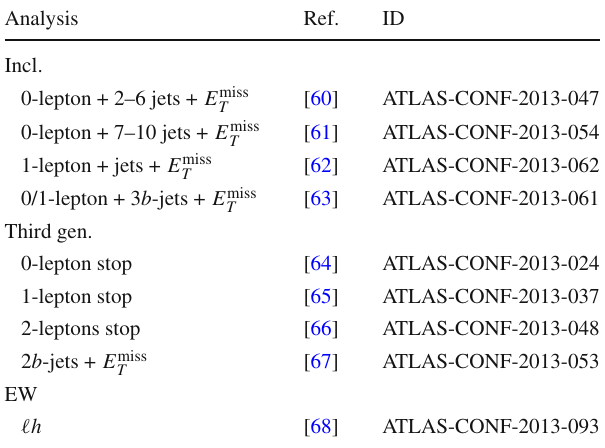
Table 2 Analyses covered by the Fastlim [33] EMs converted to the SModelS format. For each analysis, Fastlim considers 24 topologies covering stop-, sbottom- and gluino-pair production with direct or cas- cade decays to a higgsino LSP, inspired by the idea of “natural SUSY”. As explained in the text, efficiencies with uncertainties > 25% are set to zero, so in practice we use 163 of the Fastlim EMs